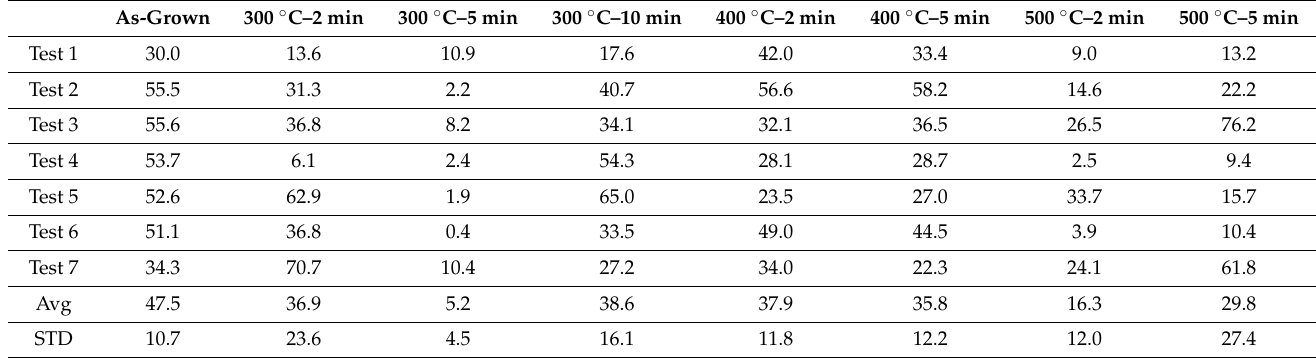
Figure 4a exemplifies the interface trap density (D it ) of the samples and as-grown sam- ple under different treatment conditions; the trap density was calculated with the conduc- tance method by considering the series resistance correction with the following equation: